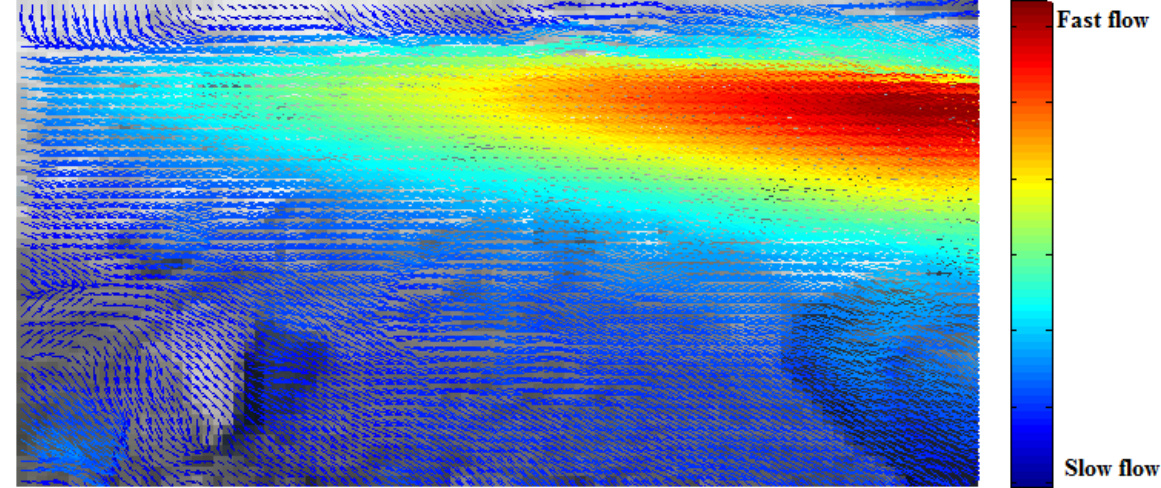
Figure 6. Color flow vectors, their magnitude are blue=slow flow and red=fast